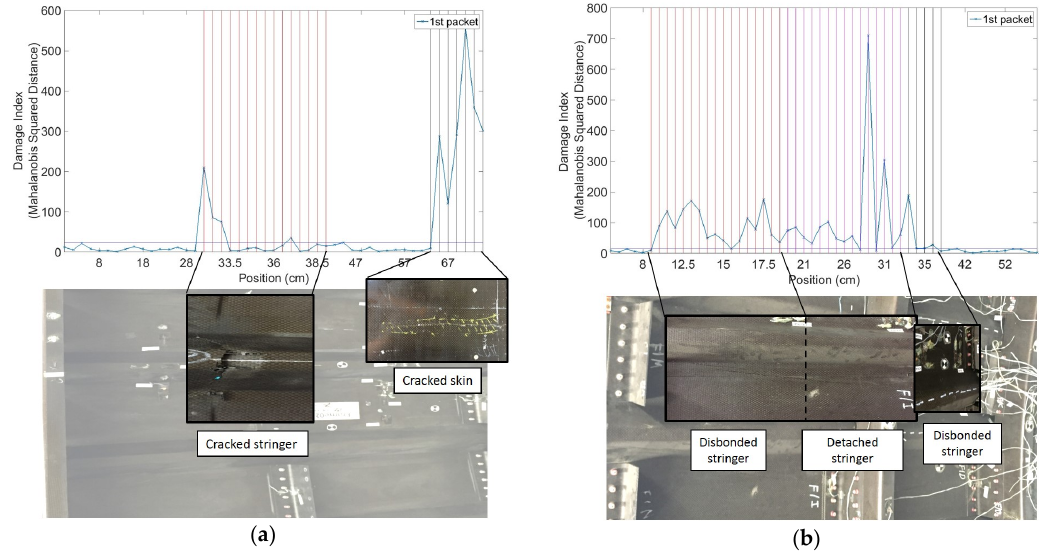
Figure 5. Representative results from contact UGW scans: ( a ) Panel 1; ( b ) Panel 2.